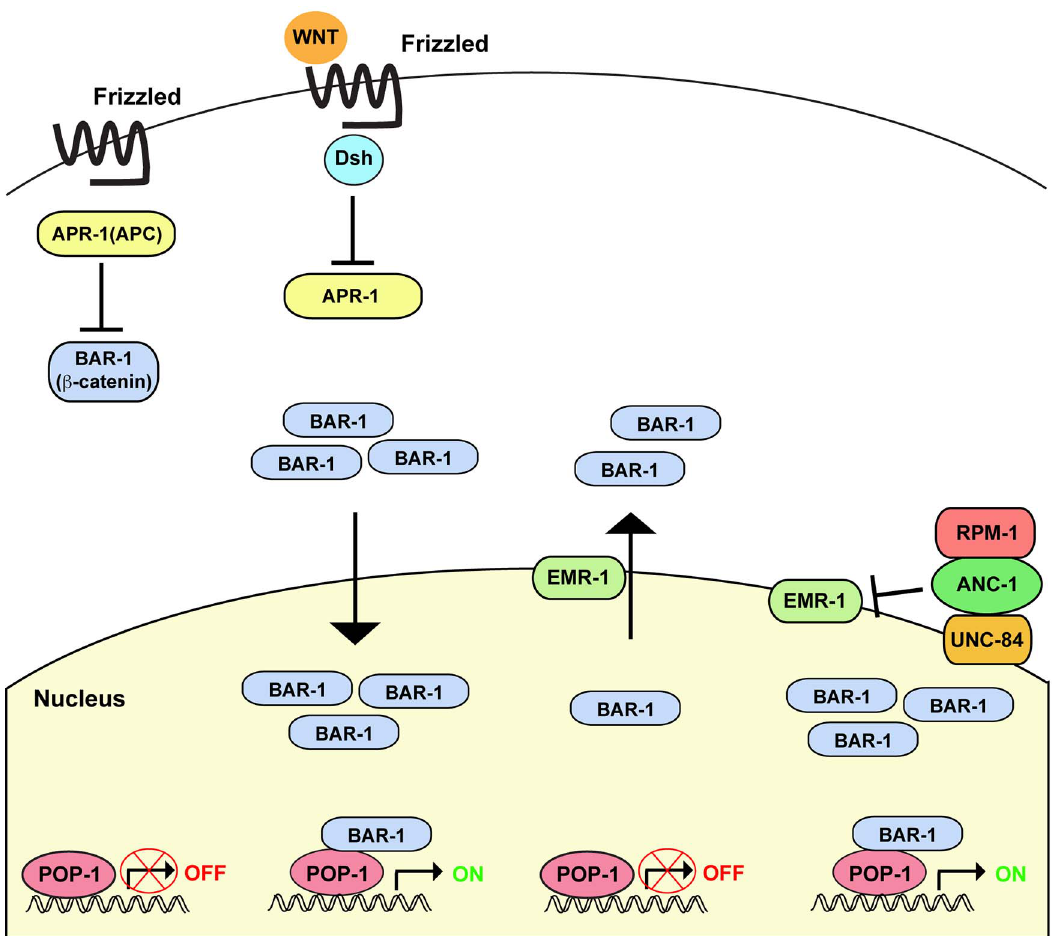
Figure 8. Summary of RPM-1 signaling through the ANC-1/BAR-1 pathway. Canonical Wnt signaling through Disheveled (Dis) and APR-1 (APC ortholog) regulates the b -catenin BAR-1. In the absence of Wnt, APR-1 is active and inhibits BAR-1. In the presence of Wnt, APR-1 is inhibited and BAR-1 activity is increased. Higher levels of BAR-1 lead to increased nuclear import and activation of the transcription factor POP-1 (TCF/LEF). We have shown that RPM-1 binds to ANC-1, and RPM-1 and ANC-1 function in the same pathway to positively regulate BAR-1 activity. RPM-1 and ANC-1 are likely to function in a protein complex at the nuclear envelope to regulate BAR-1 nuclear levels by inhibition of EMR-1. Canonical Wnt signaling is likely to act coordinately with RPM-1 and ANC-1 to regulate BAR-1 activity.